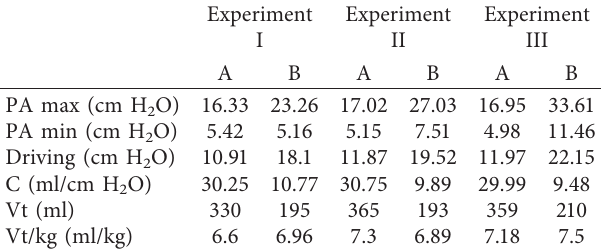
Table 7: Stage 3 in